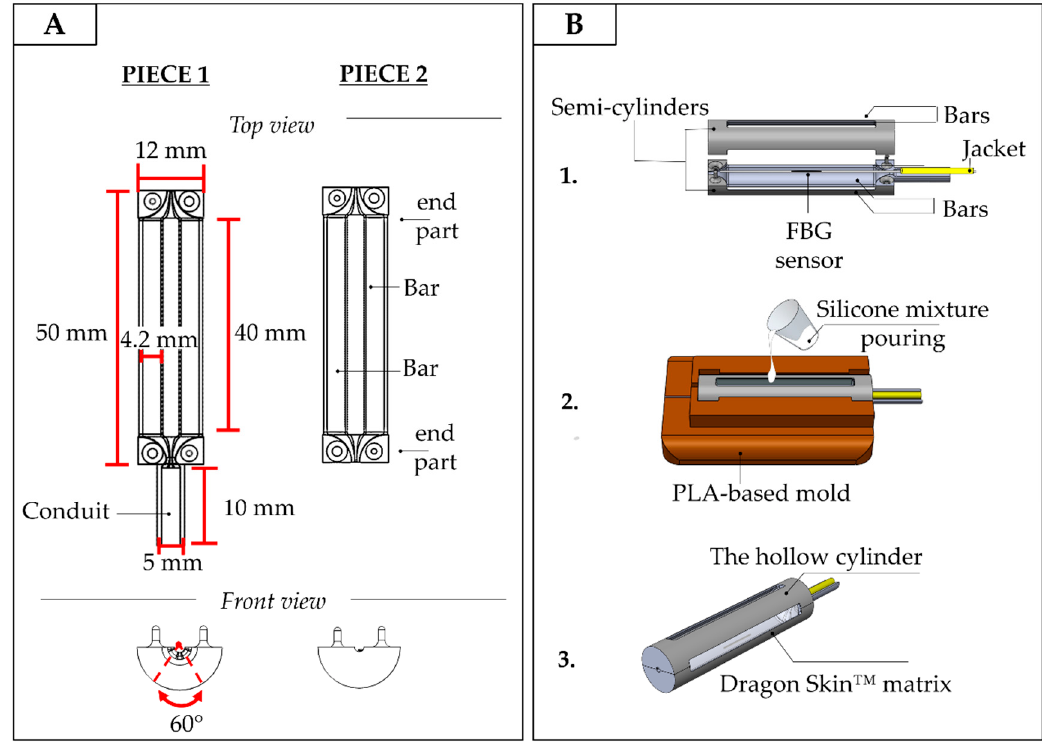
Figure 4. ( A ) The geometrical features of an SGD; ( B ) The main manufacturing steps: the FBG sensor positioning (step 1), the silicone mixture pouring (step 2), and the SGD removed from the mold after the rubber vulcanization (step 3).